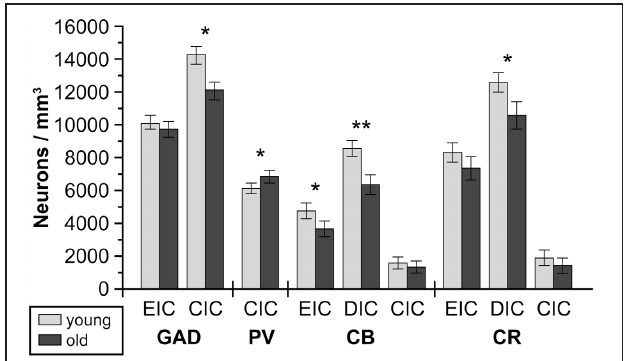
FIGURE 3 | The numerical density of GAD67-ir, PV-ir, CB-ir and CR-ir neurons in the external and dorsal cortices and in the central nucleus of the IC in young and old Long-Evans rats. CIC, central nucleus of the inferior colliculus; DIC, dorsal cortex of the inferior colliculus; EIC, external cortex of the inferior colliculus; GAD67, glutamate decarboxylase, isoform 67; PV, parvalbumin; CB, calbindin; CR, calretinin. The displayed results represent a summary of graphs from Ouda et al. (2008); Burianova et al. (2009); Ouda et al. (2012b). The error bars represent S.E.M. ( ∗ P < 0 . 05, ∗∗ P < 0 .